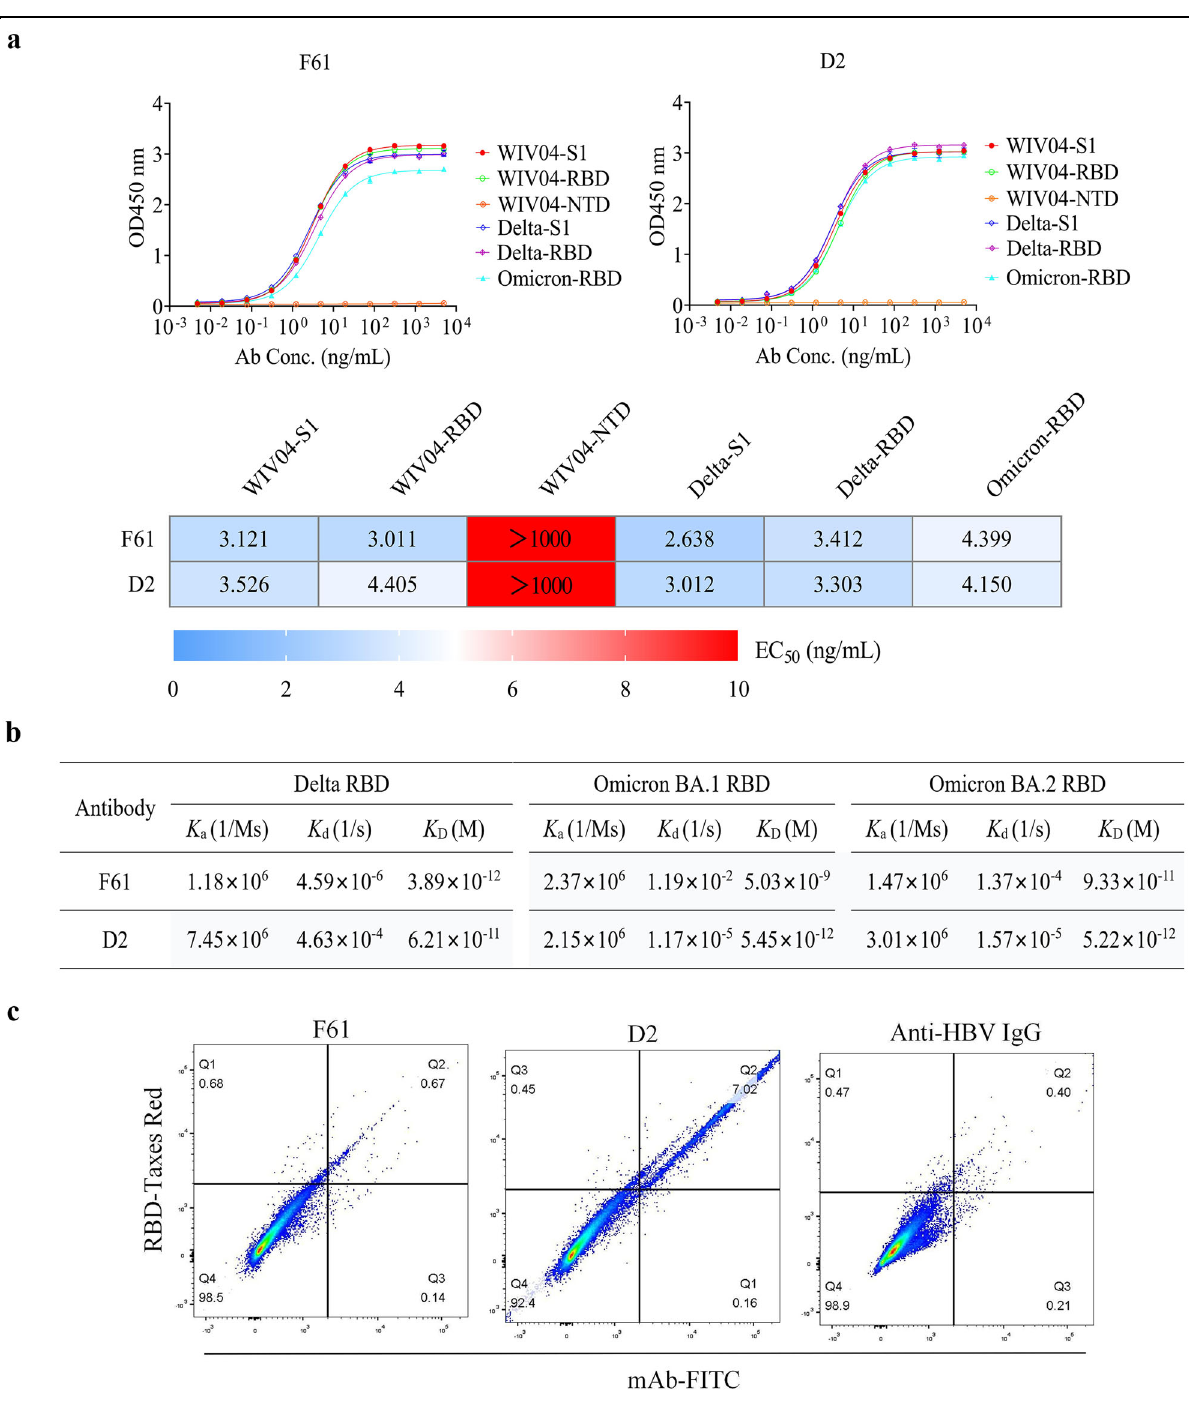
Fig. 1 Biochemical characterization of neutralizing antibodies F61 and D2. a Binding pro fi les of F61 and D2 to different spike proteins (WIV04- S1, WIV04-RBD, WIV04-NTD, Delta-S1, Delta-RBD and Omicron-RBD) were determined by ELISA. F61 and D2 bound to diverse RBD and S1 fragments but not WIV04-NTD with EC 50 values less than 4.5 ng/mL, indicating that they were both RBD-speci fi c antibodies. Experiments were performed in duplicate, n = 2. Data are represented as means ± SD (upper panel) and means (down panel). b Binding kinetics ( K D ) of the monoclonal antibodies (mAbs) with Delta-RBD, Omicron-RBD (BA.1 and BA.2) were measured by SPR. c mAbs blocked SARS-CoV-2 WT-RBD binding to ACE2 measured by FACS. The X-axis represented the fl uorescence intensity of human antibodies labeled by FITC, and the Y-axis represented the fl uorescence intensity of RBD-mFc labeled by Taxes Red. Percentages of cells that scored negative, single positive, or double positive are shown in each